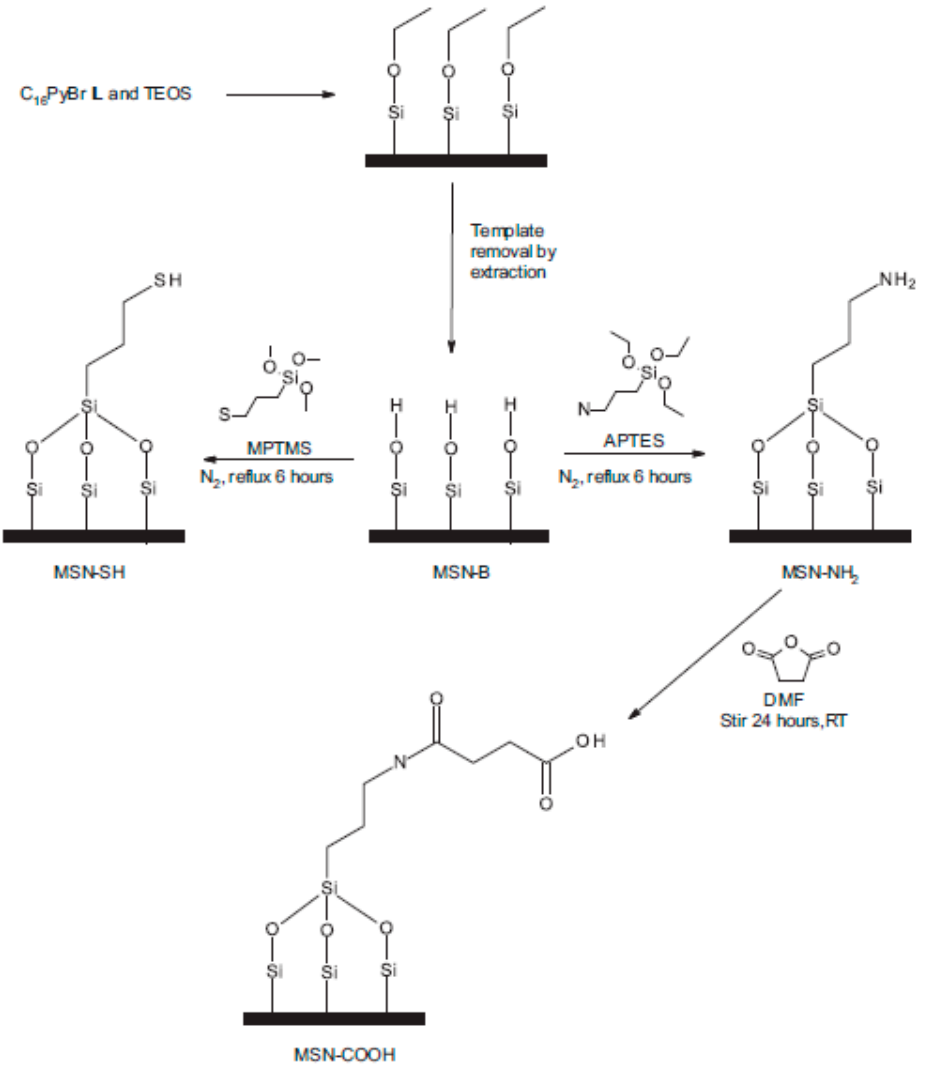
Figure 13. Schematic representation for the fabrication of functionalized mesoporous silica nano- particles [200]. Reprinted with permission from ref. [200]. Copright 2021